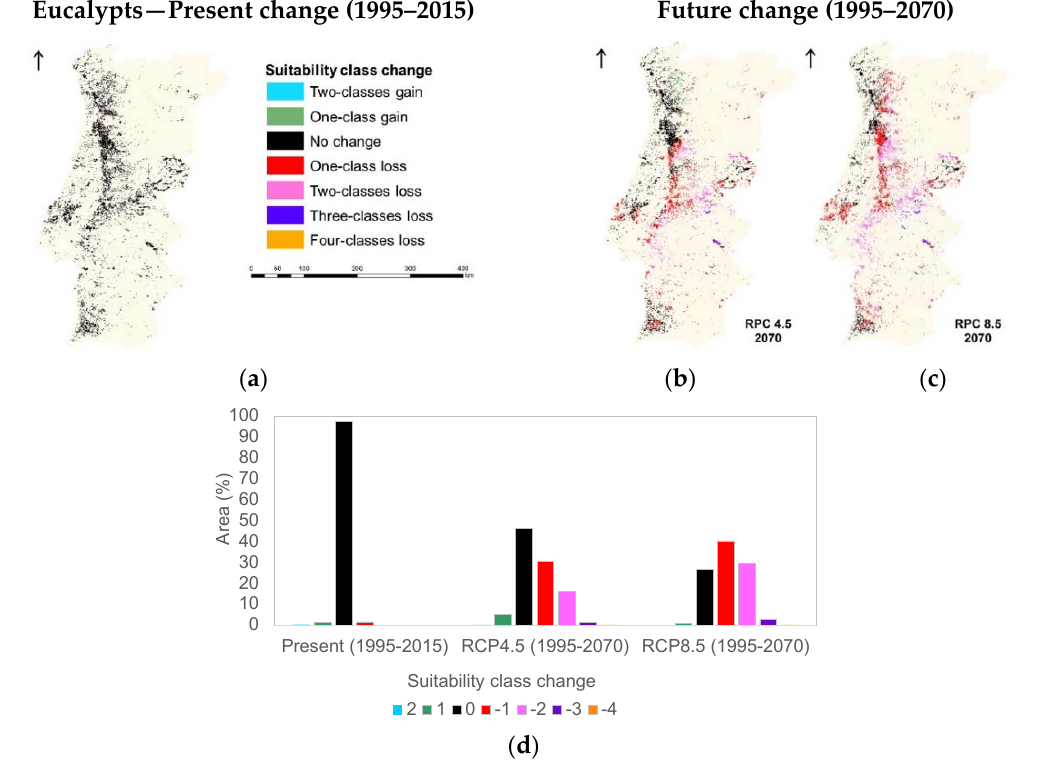
Figure A2. Species distributions—ecological envelopes class change: ( a ) Present (1995–2015); ( b ) Future RCP4.5 scenarios (1995–2070); ( c ) Future RCP8.5 scenarios (1995–2070); and ( d ) Suitability classes change percentage areas distribution. Table A2. Bayesian networks—Relative Mutual Information (RMI) and Relative Significance (RS): species presence (maritime pine—Pb95; and eucalypts—Ec95); species productivity (maritime pine—SI 50 ; and eucalypts—SI 10 ) and the correspondent climatic (1960-1990), topographic and soil variables (most contributive variables highlighted in bold—RS > 70% and RMI sum >